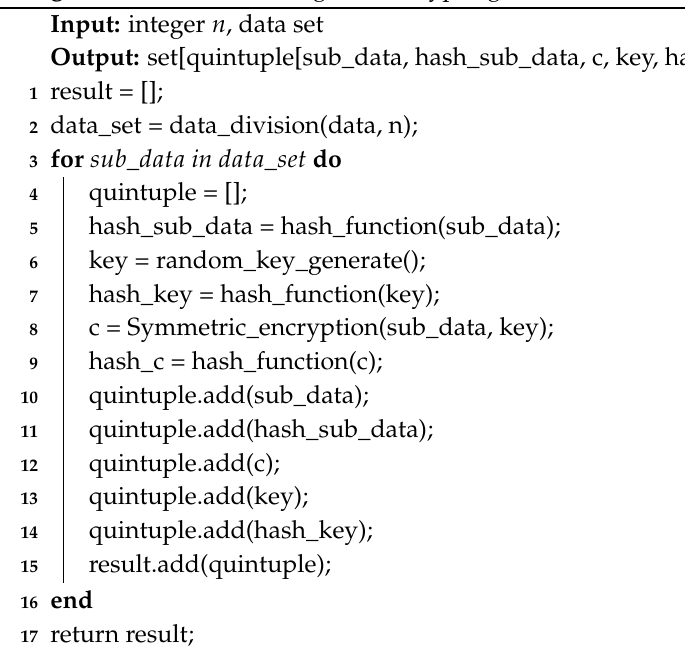
Algorithm 1: Data blocking and encrypting